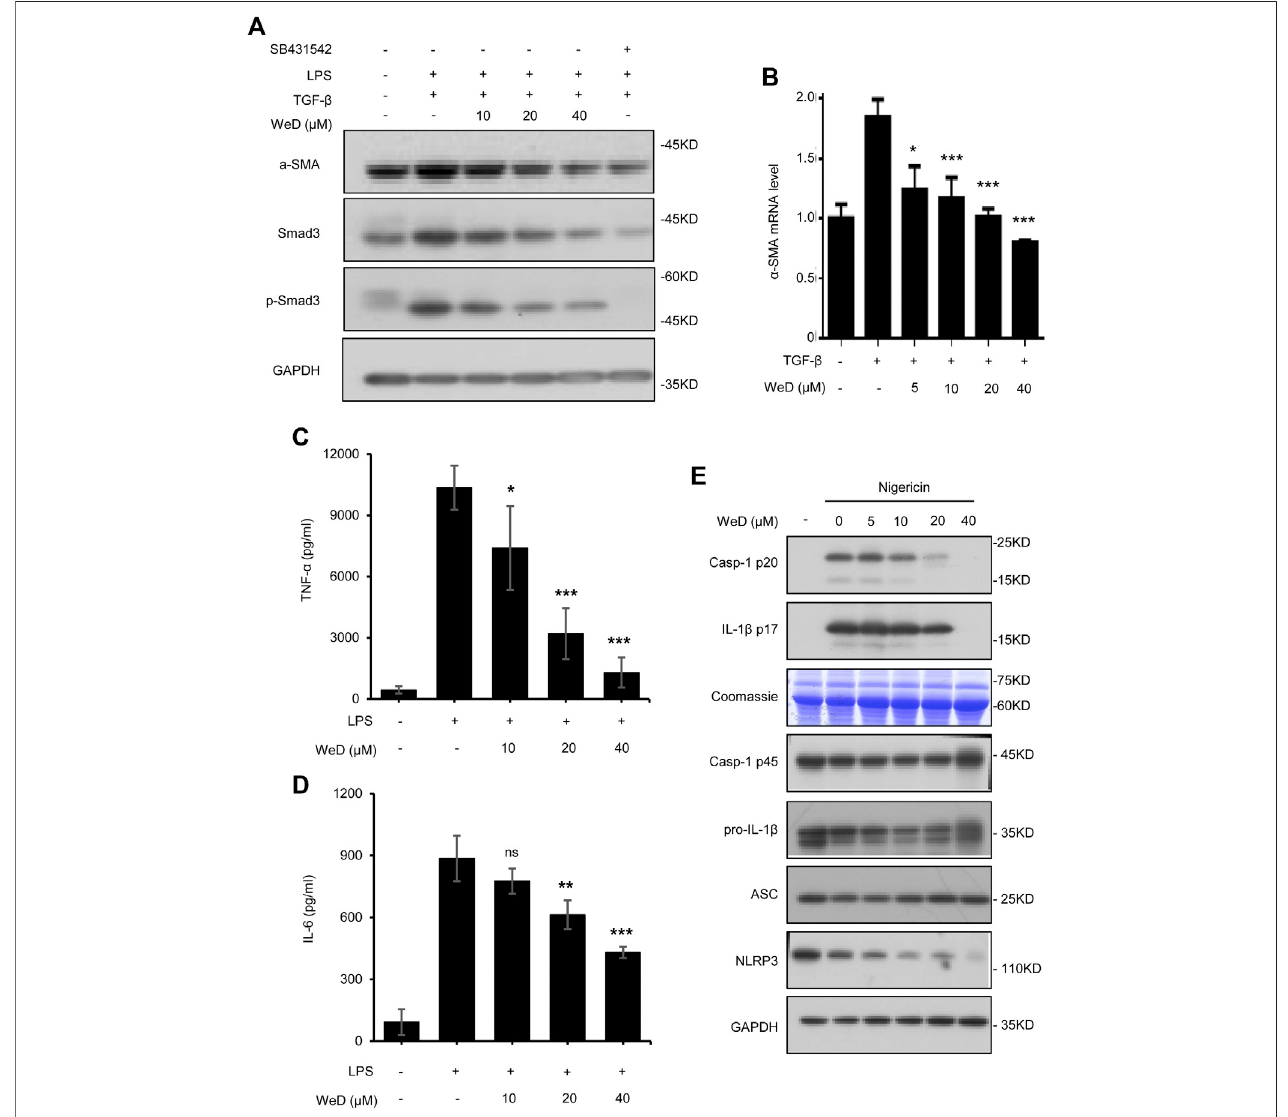
FIGURE 3 | WeD inhibits TGF- β 1/Smad-mediated activation of HSCs and blocks the production of TNF- α and IL-1 β in macrophages (A) Western blot analysis of α -SMA, Smad3, p -Smad3, GAPDH in LX-2 cells treated with WeD (10, 20, 40 μ M) and then stimulated with TGF- β 1 (5 ng/ml) combined with LPS (50 ng/ml) (B) Quantitative PCR analysis of mRNA levels of α -SMA of LX-2 cells treated with WeD and then stimulated with TGF- β 1 (5 ng/ml) (C,D) ELISA of TNF- α (C) and IL-6 (D) in SNofBMDMs treated withWeD (10,20,40 μ M) and thenstimulatedwithLPS(50 ng/ml) (E) Western blotanalysisofcaspase-1(p20) andIL-1 β inSNand pro- IL- 1 β , caspase-1 (p45), NLRP3 and ASC in WCL of LPS-primed BMDMs treated with WeD (5, 10, 20, 40 μ M) and then stimulated with nigericin. Data are expressed as Mean ± SD from three biological replicates ( n (cid:2) 3). Statistics differences were analyzed using One-way ANOVA followed by Dunnett ’ s test: * p < 0.05, ** p < 0.01, *** p < 0.001. NS, no signi fi